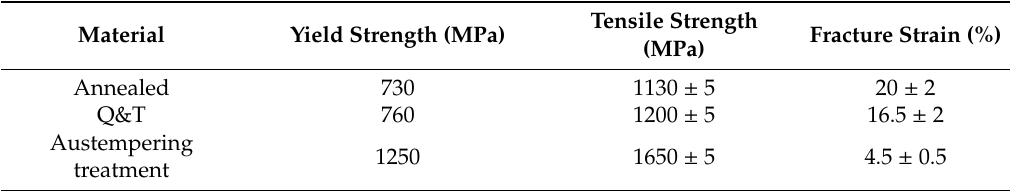
Figure 14. Engineering stress-strain curves. Blue curve with blue circle is related to austempered samples, red curve with diamonds referred to the Q&P treatment and green curve with squares representing the annealed samples. Table 5. Results of tensile tests.